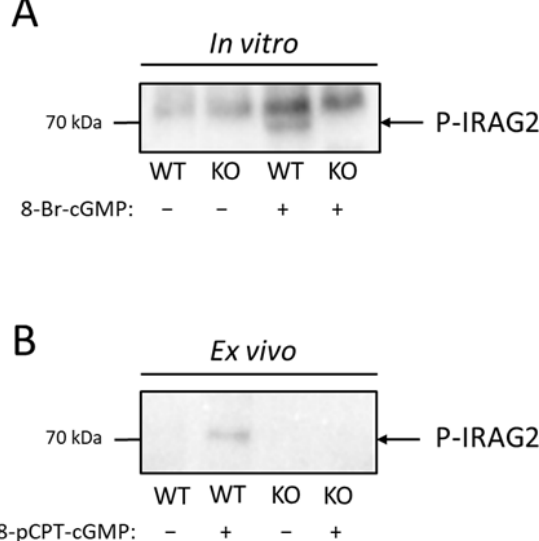
Figure 3. Phosphorylation of IRAG2 in platelets in vitro and ex vivo. ( A , B ) Platelets of IRAG2-WT